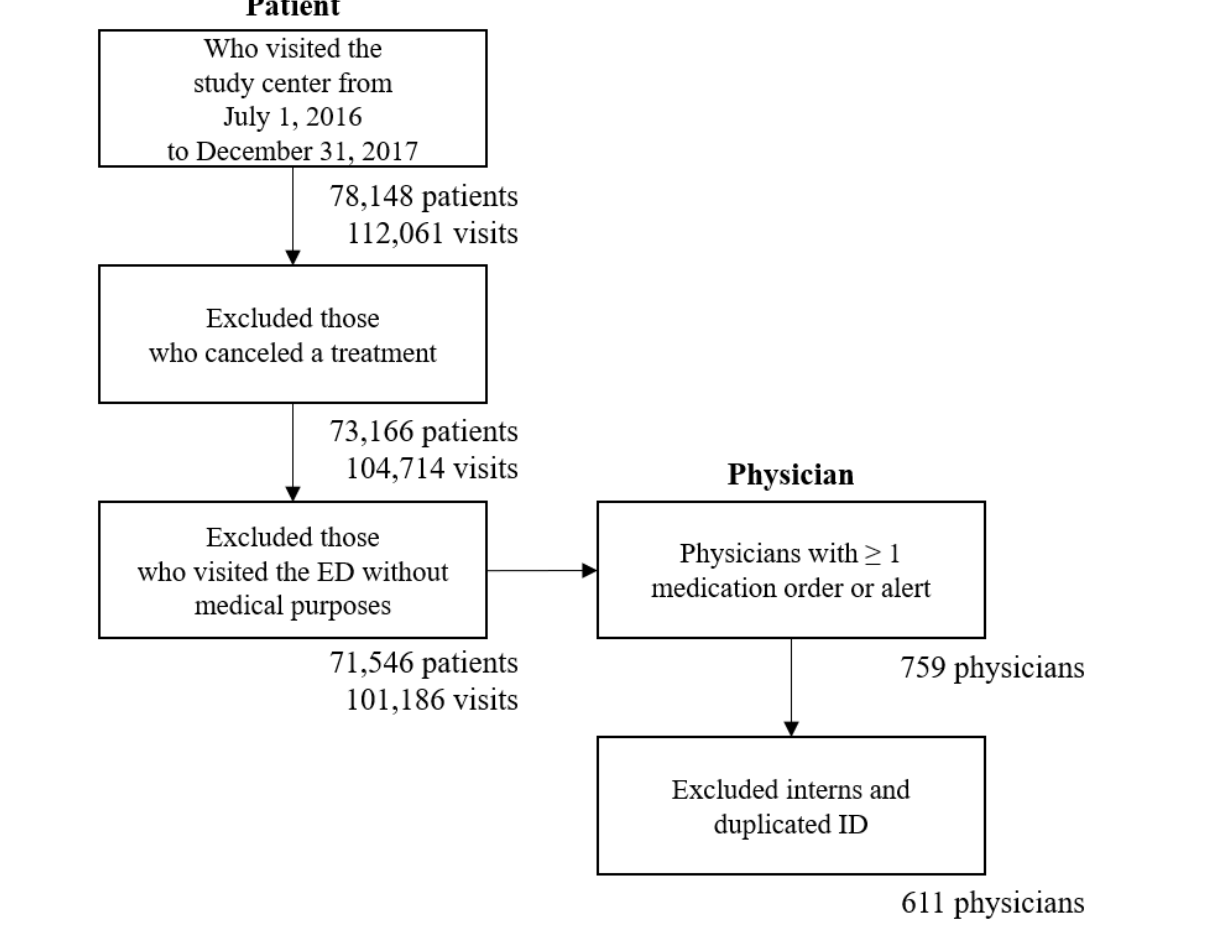
Table 1. Description of the alert overrides determining logic.